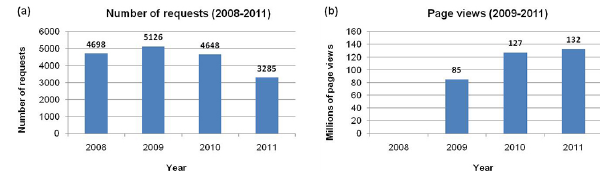
Figure 5. Total number of requests received in the SMC during the years 2008, 2009, 2010 and 2011 and website statistics (page views) of www.meteo.cat during 2009, 2010 and 2011. A decrease in the requests was detected in the last few years, especially in 2011, co- inciding with an increase in said years page views.